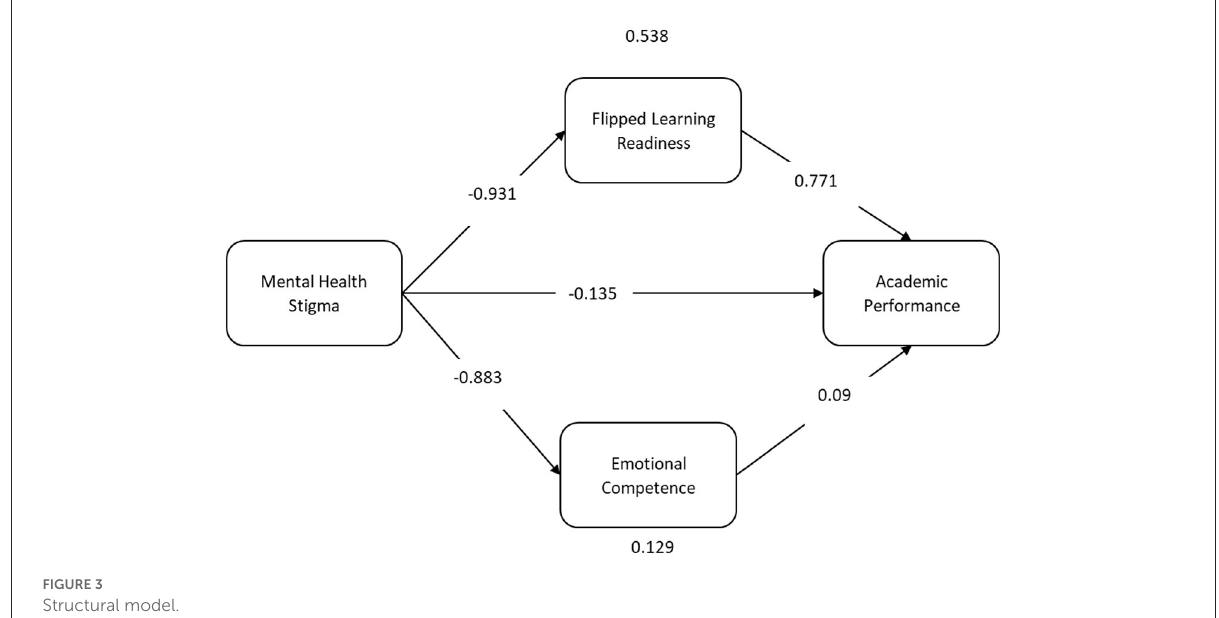
FIGURE3 Structural model.